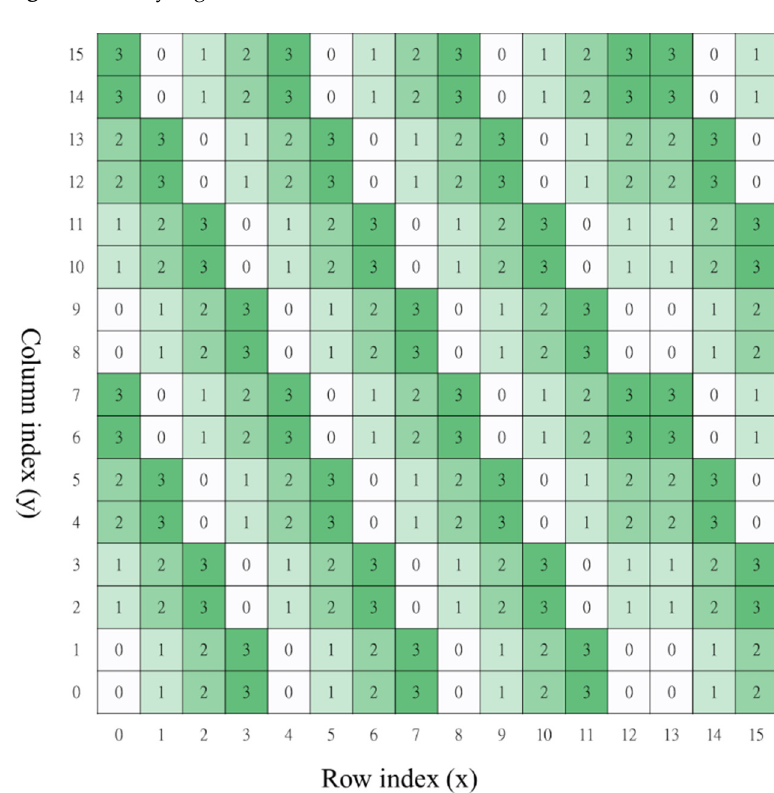
Figure 6. Waves type table WT.